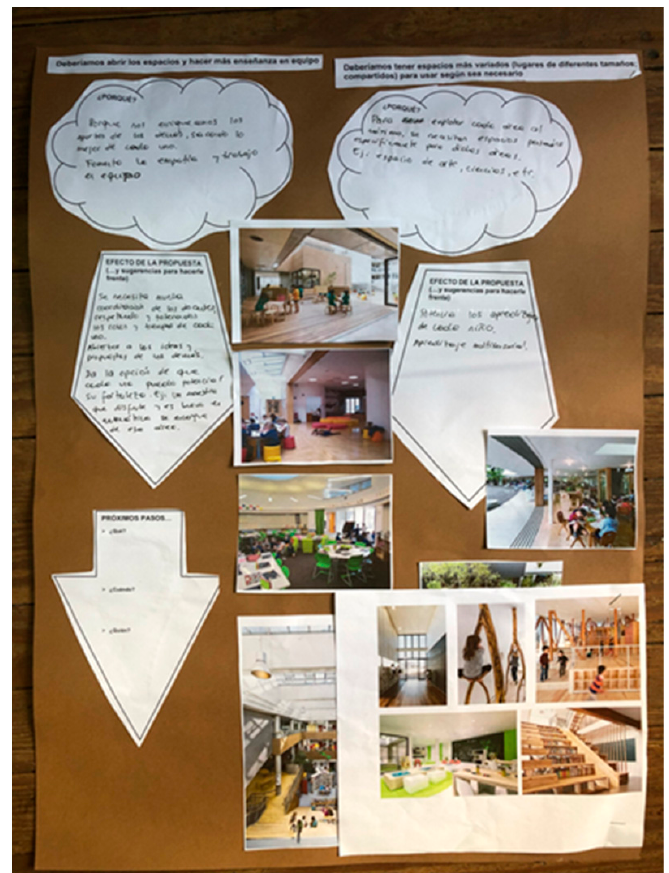
Figure 7. An example of a resulting collage by one of the groups.